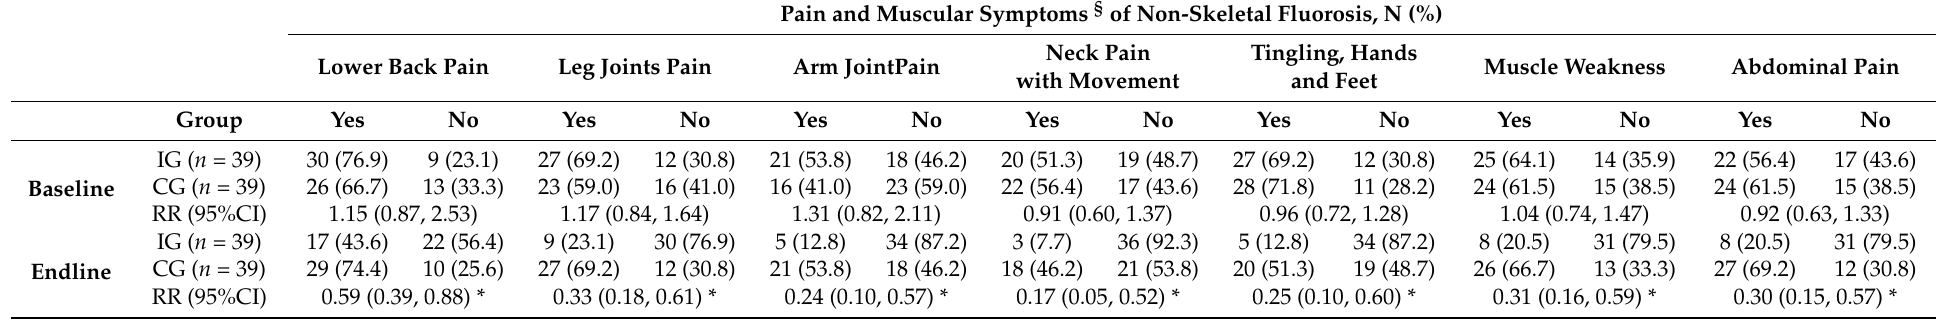
Table 5. Pain and muscular symptoms of non-skeletal fluorosis in a 6-month eggshell powder intervention between intervention and control groups. Lower Back Pain Leg Joints Pain Arm JointPain